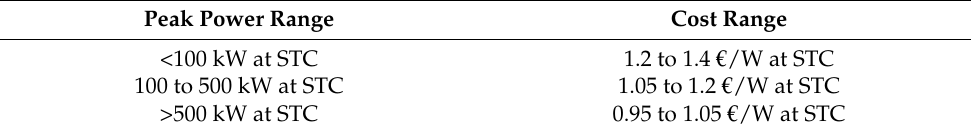
Table 4. Infrastructure costs excluding tax for PV panels installed on the car parking